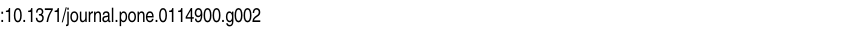
Fig. 2. Decreased 5-Year overall survival in TNBC compared to non-TNBC (n 5 314, p 5